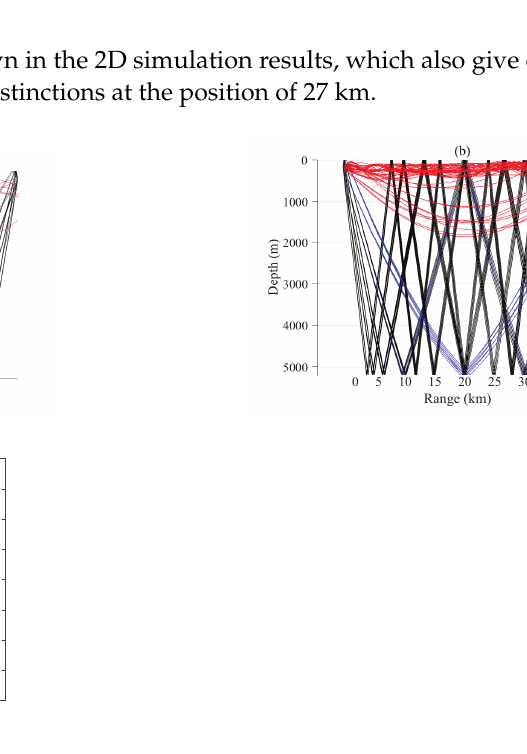
Figure 21. Comparison of sound rays between in ( a ) 2-D and ( b ) 3-D environment. Subfigure ( c ) is the top view of sound rays in 3-D simulation which showed horizontal refraction phenomenon. In the picture, red solid line is the acoustic ray and black dotted line is direction from source to the receiver.